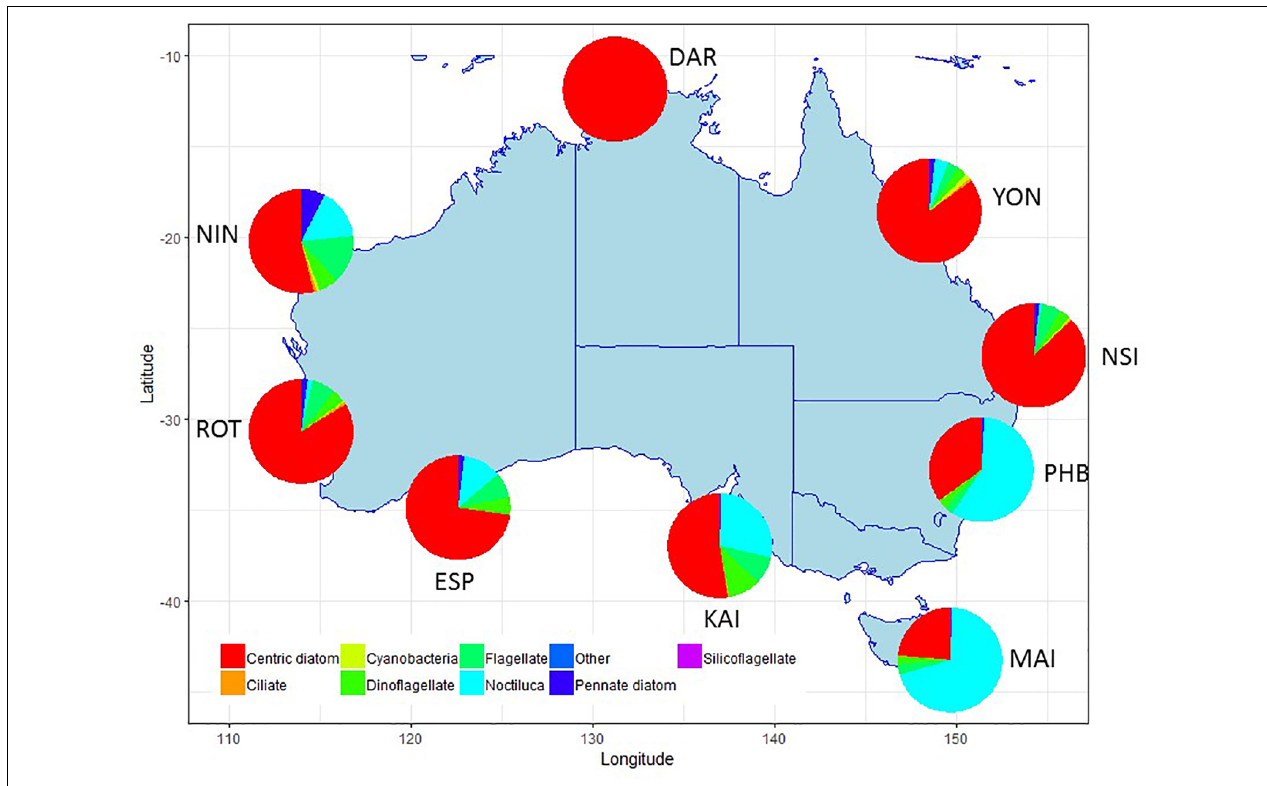
FIGURE 5 | Major taxonomic or functional groups of phytoplankton taxa counted in the NRS survey, all samples combined. Phytoplankton data presented as biovolume ( µ m 3 /L) due to the high proportion of flagellates in abundance data. Site details and codes are as per Table 1